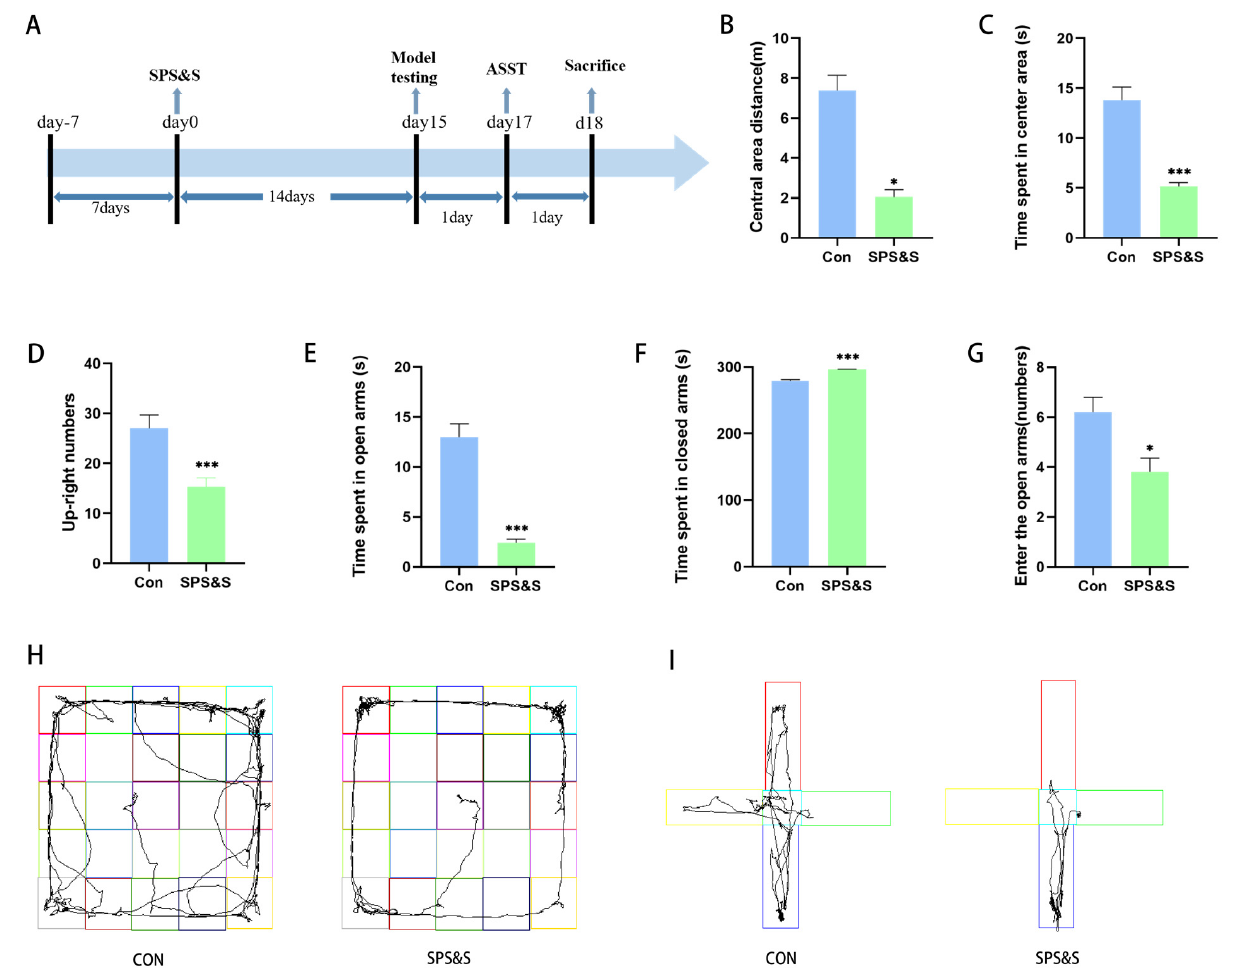
Figure 1. Effects of SPS&S procedure on rat behaviors. ( A ): The timeline of the experimental pro- cess and the events that occur at important points in time. Model testing includes an open field test (OFT) and elevated plus maze test (EPMT). After the unified behavioral test, the brain is taken, and molecular detection is carried out. Behavioral tests results are shown the movement distance and time spent by the rats in the center of the OFT ( B , C ), the up-right numbers of rats in the OFT ( D ), the time spent by rats in open arms and closed arms in the EPMT ( E , F ), the number of times the rats entered open arms in the EPMT ( G ). The ( H , I ) diagrams showed the movement tracks of the rats in the OFT and EPMT, respectively. The results are expressed as mean ± standard deviation. * p < 0.05 and *** p < 0.001. 3.2. Effects of SPS&S-Induced Cognitive Flexibility The results of the ASST test showed significant main effects of stress (F (1, 18) = 13.343, p = 0.002 ** ) and stage (F (6, 108) = 7.785, p = 0.000 ***), but no significant stress × stage interaction effect (F (6, 108) = 2.292, p = 0.040 ** ). Furthermore, a t-test for each stage in the ASST revealed that the SPS&S rats showed a significantly increased number of TTC in every shift (ID: t 18 = − 2.618, p = 0.022 *; ED: t 18 = − 3.021, p = 0.008 **). The rats in the Con and SPS&S groups performed ID shifts more rapidly than ED shifts in the same group ( p < 0.05), demonstrating that the rats formed the attentional set. Moreover, the SPS&S-sup- plemented rats required significantly more TTC in the CD, R1, R2, and R3 phases com- pared to the SPS&S group in the same stages ( p < 0.05). The data showed that the overall cognitive performance of the Con rats was better than the SPS&S rats. In addition, the successful set formation was validated by comparing the ratio of the trials needed to reach the criterion in the ED as compared to the ID stages. Both groups showed ED/ID ratios